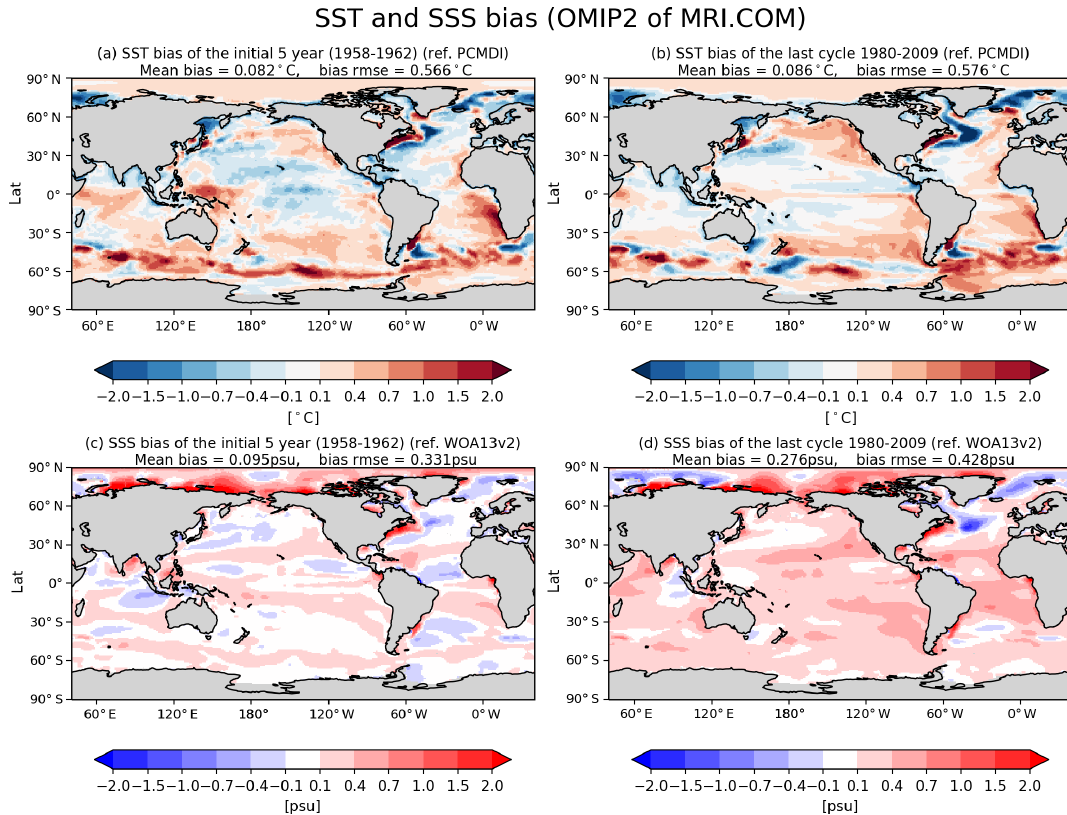
Figure 8. Comparison of SST (a, b) and SSS (c, d) biases relative to observations (PCMDI-SST and WOA13v2, respectively) for the initial 5-year mean (a, c) and the long-term mean (1980–2009) in the last cycle (b, d) from the OMIP-2 simulation of MRI.COM. Pattern correlation of biases between the initial 5-year mean and the long-term mean in the last cycle is 0.75 for SST and 0.85 for